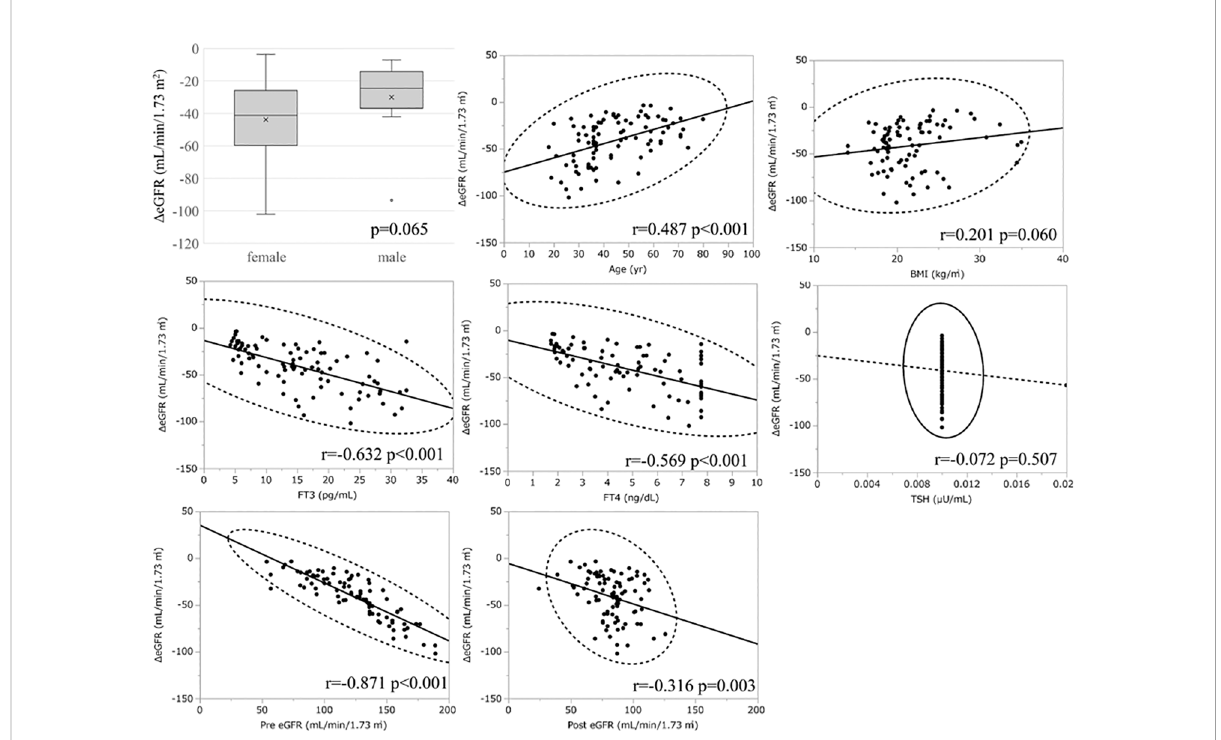
FIGURE 1 Association between D eGFR and variables in hyperthyroidism. D eGFR of male and female, and scatter blot analysis between D eGFR and variables, age, gender, BMI, post-eGFR, pre-eGFR, FT3, FT4,